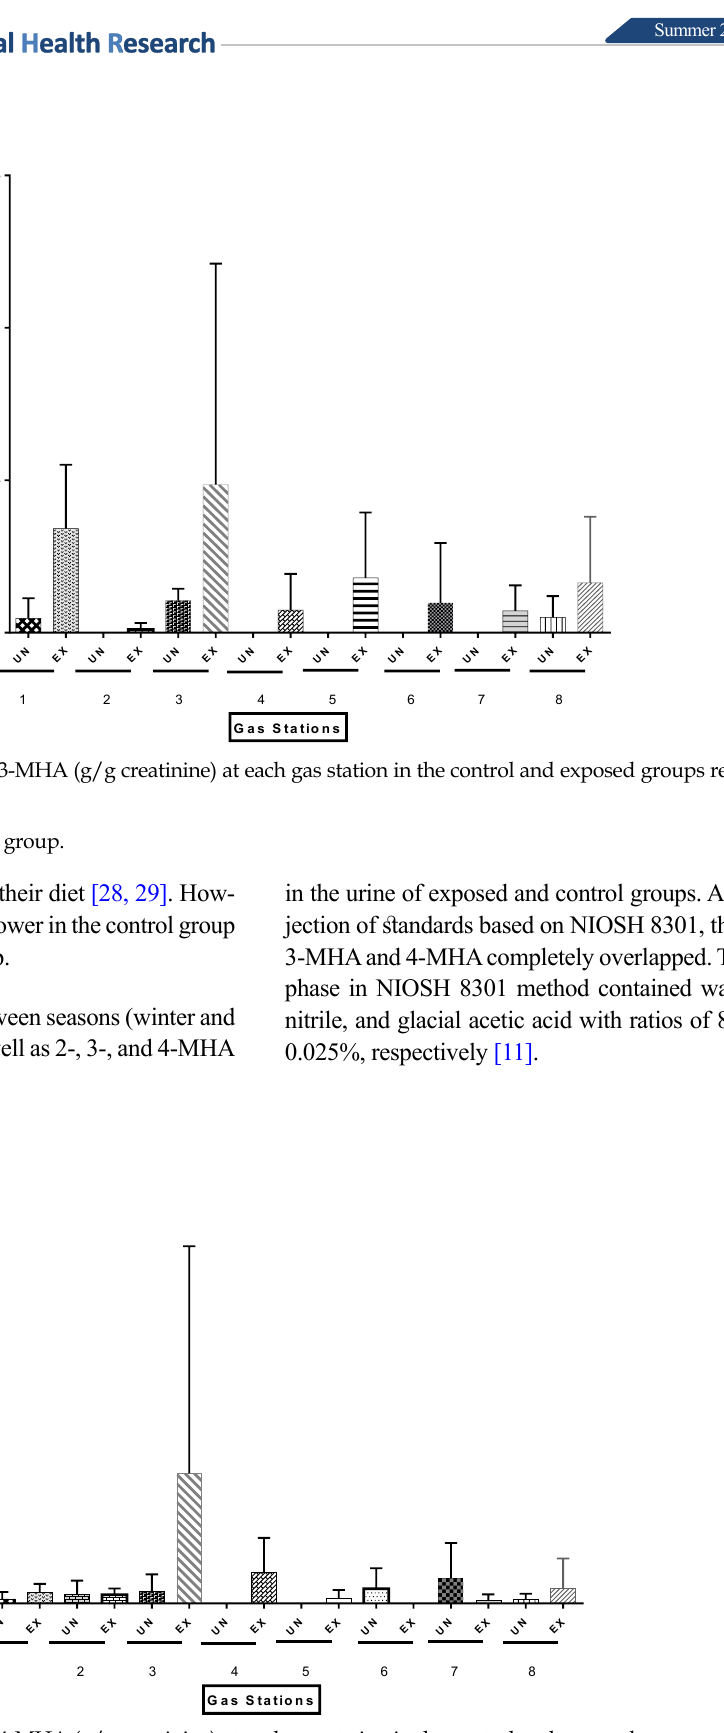
Figure 4. Mean concentrations of 4-MHA (g/g creatinine) at each gas station in the control and exposed groups regardless of the season variable Figure 4. The Mean Concentrations of 4-MHA (g/g creatinine) at Each Gas Station in the Control and Exposed Groups UN: Control group; EX: Exposure Regardless of the Season Variable (UN: control group; EX: exposure group)